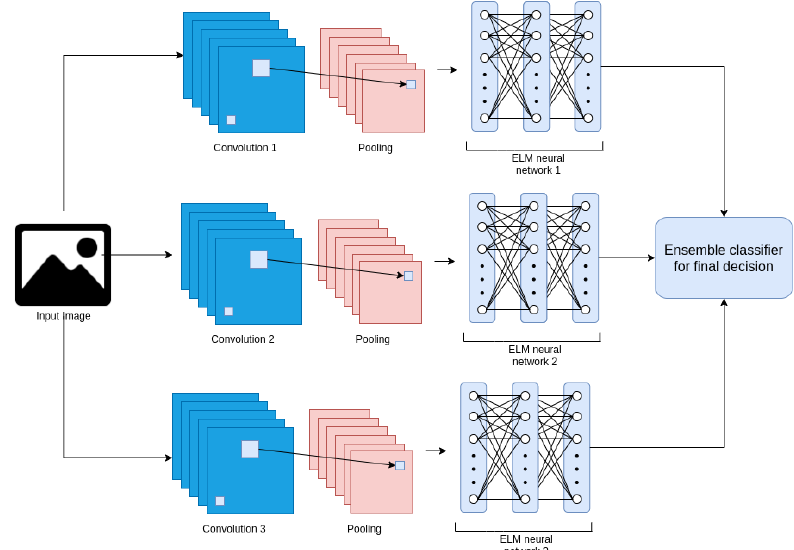
Figure 7. Example of ensemble representation for CELM. Three different CELM architectures are used for feature extraction and learning process. At the end, an operator is responsible for making the final classification